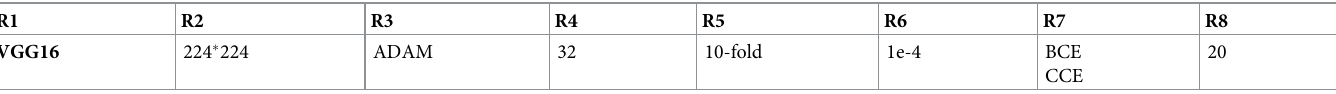
Table 3. Hyper-parameters of the VGG16 model and preferred weights in this study. R1